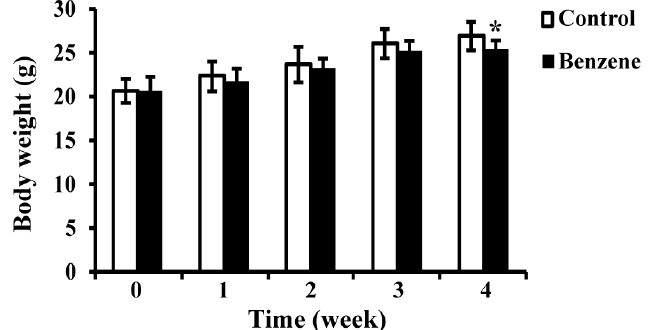
Figure 1. Effects of benzene exposure on body weight (g). Data are represented as the Mean ± SD ( n = 8). * p < 0.05 compared with control group.